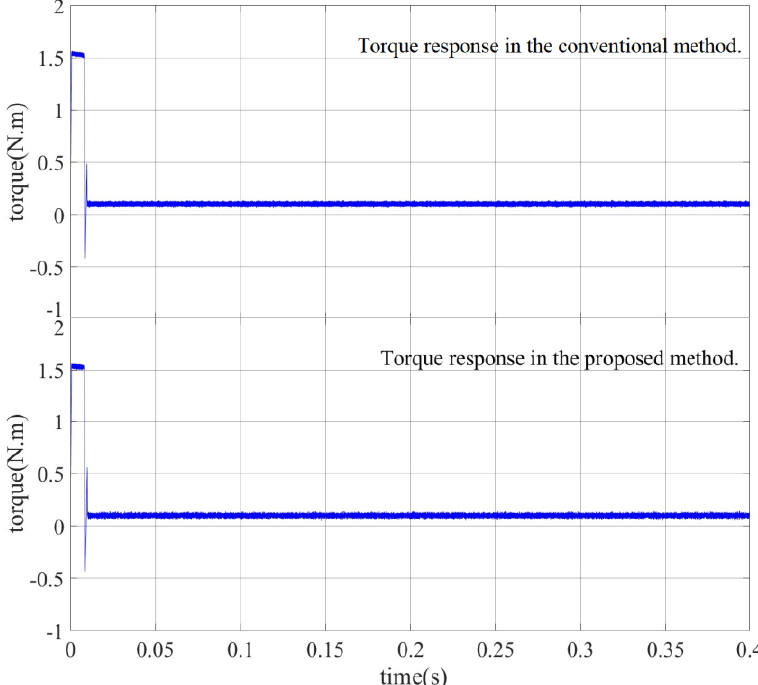
Figure 11. Torque response when the motor is in the approximately no-load state.